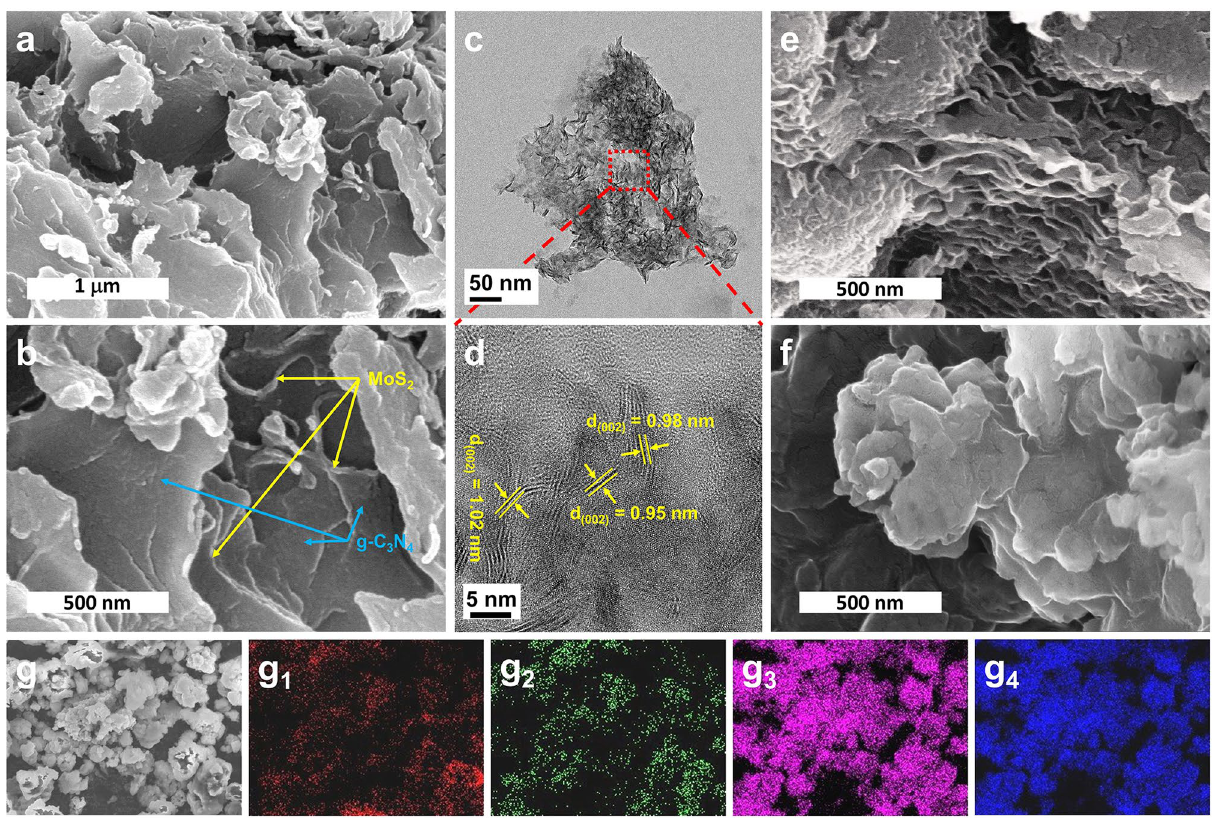
Figure 2. ( a , b ) FE-SEM; and ( c , d ) HR-TEM images of MCN-500; FE-SEM images of ( e ) MCN-600; and ( f ) CN-500; EDS mapping images of ( g ) mapping area, ( g 1 ) carbon, ( g 2 ) nitrogen, ( g 3 ) sulfur, and ( g 4 )